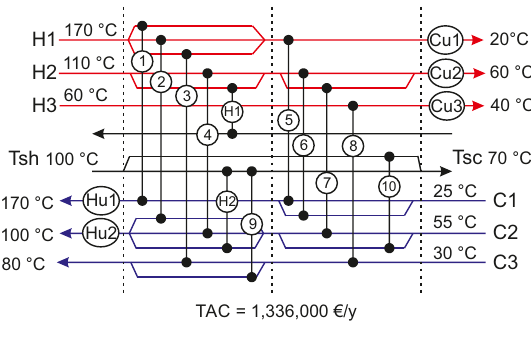
Figure 5. HEN obtained with HP and ST options case 2.